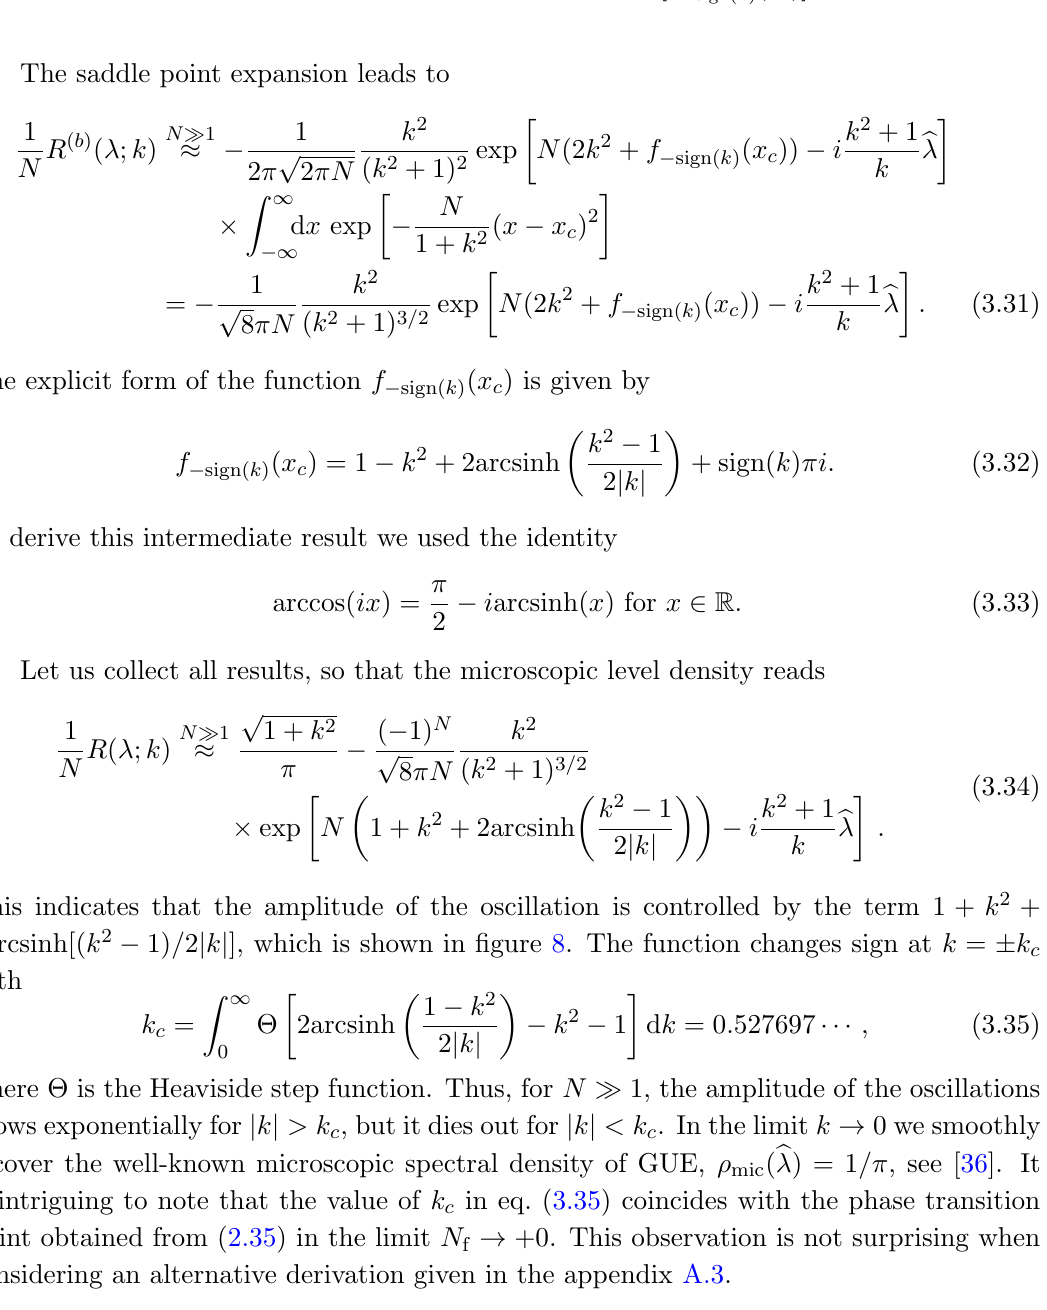
Figure 8 . Shown is the function 2 k 2 + Re[ f